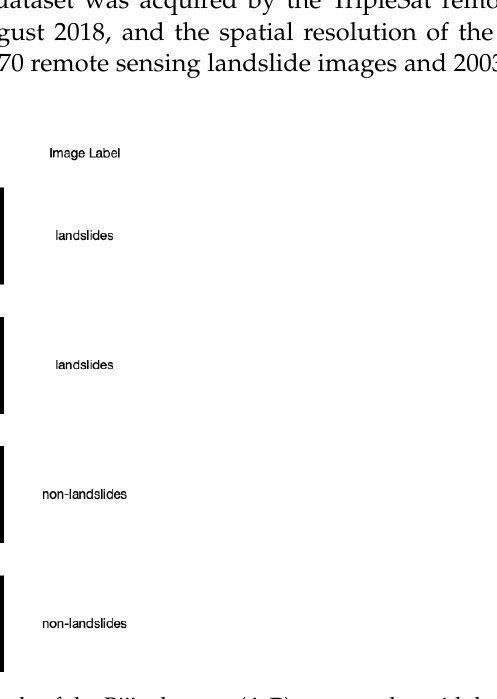
Figure 1. Some images and labels of the Bijie dataset. ( A , B ) are samples with landslides, ( C , D ) are samples without landslides.